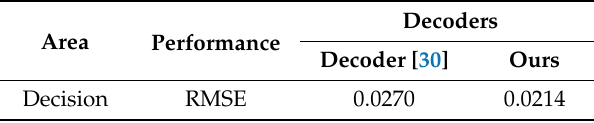
Table 3. The RMSE of the two decoders in the decision